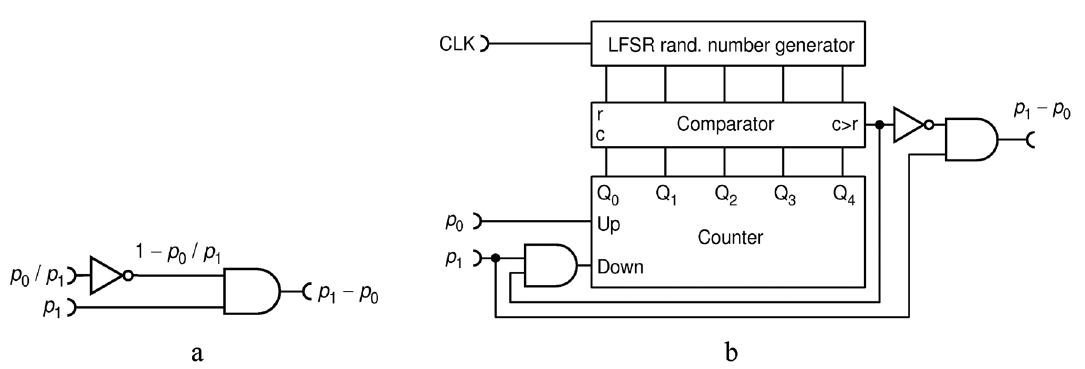
Figure 15. Relative KS entropy of the output of the three division circuits that approximately calculate p 0 / p 1 , for p 1 = 0.1, 0.5 and 0.9, for a counter of N = 4 bits (a) and N = 8 bits (b) .